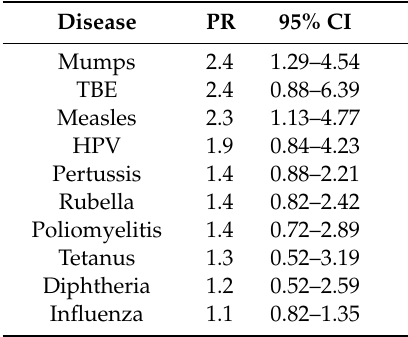
Table 6. Association (prevalence ratio (RR) and 95% confidence interval (95% CI)) of the preference of alternative medicine and intention to